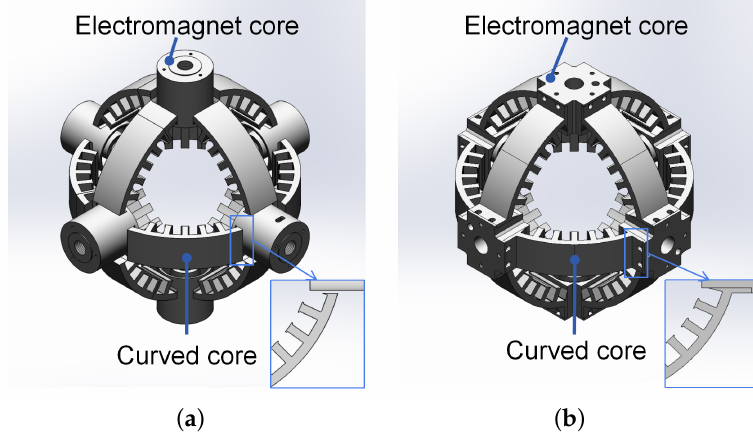
Figure 3. Structural design of the stator cores: ( a ) original design and ( b ) improved